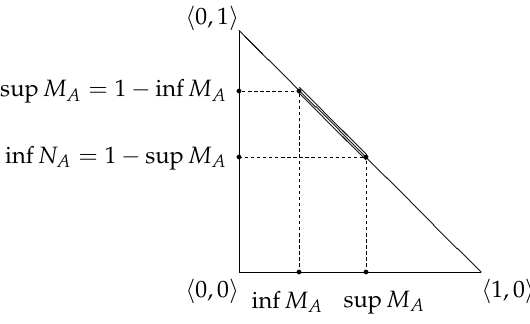
Fig. 3. The second geometrical interpretation of an IVFS. Figure 3. The second geometrical interpretation of an